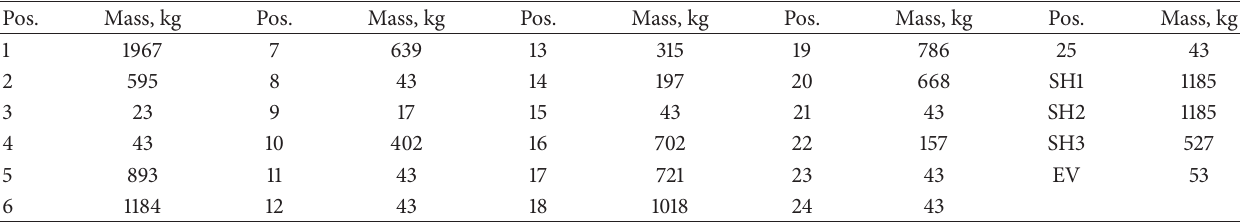
Table 2: Masses of constituent structural elements for half geometry of “Milano” boiler.